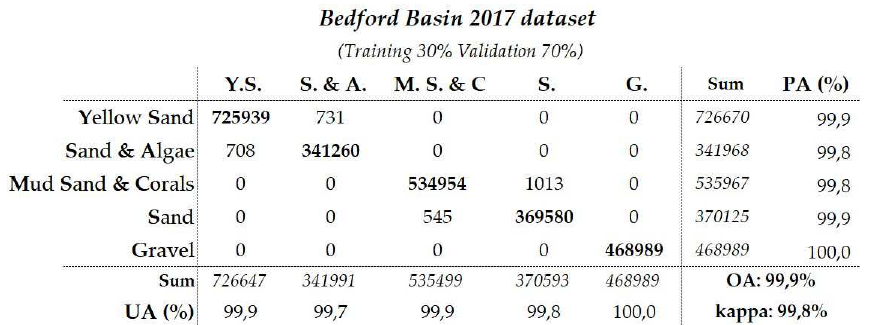
Table 2: The calculated Confusion Matrix of Bedford Basin 2017 as resulted from a RF